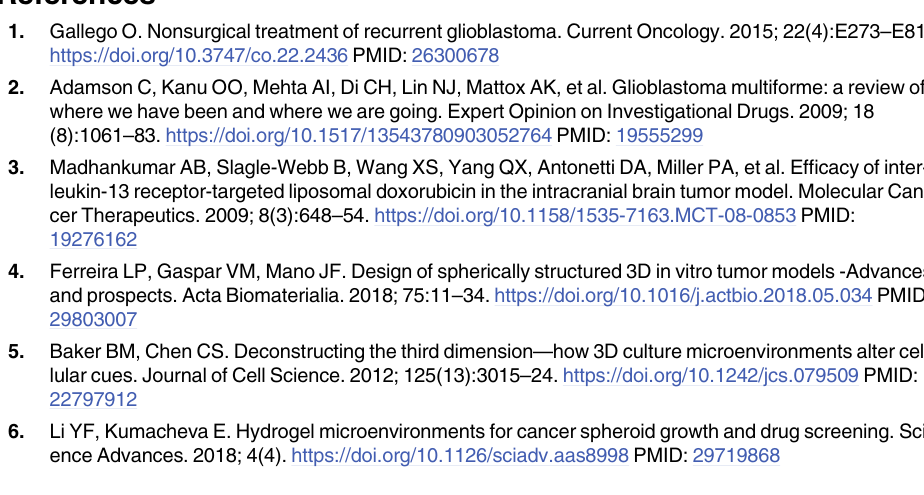
S1 Fig. Formation of multiple spheroids in large microwells. Optical image of multiple U251 spheroids formed in a representative 700 μ m